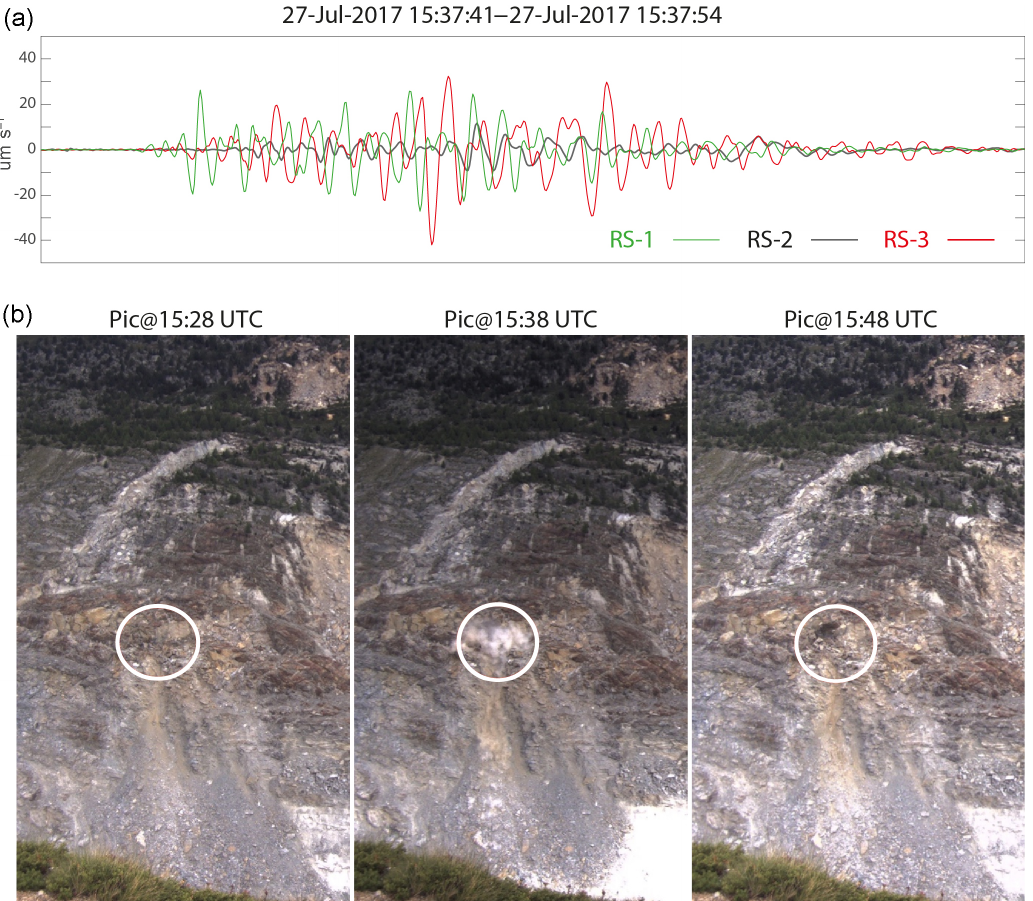
Figure 5. Details of a rockfall event that occurred on 27 July 2017 around 15:37UTC. (a) Seismic signal is clearly visible at the three RS stations. Note the differences in amplitudes and phases. (b) Three snapshots with 10-min baseline acquired by the webcam. The rockfall event is clearly visible (white circle). Future work will jointly exploit seismic and optical images to locate and characterize rockfall